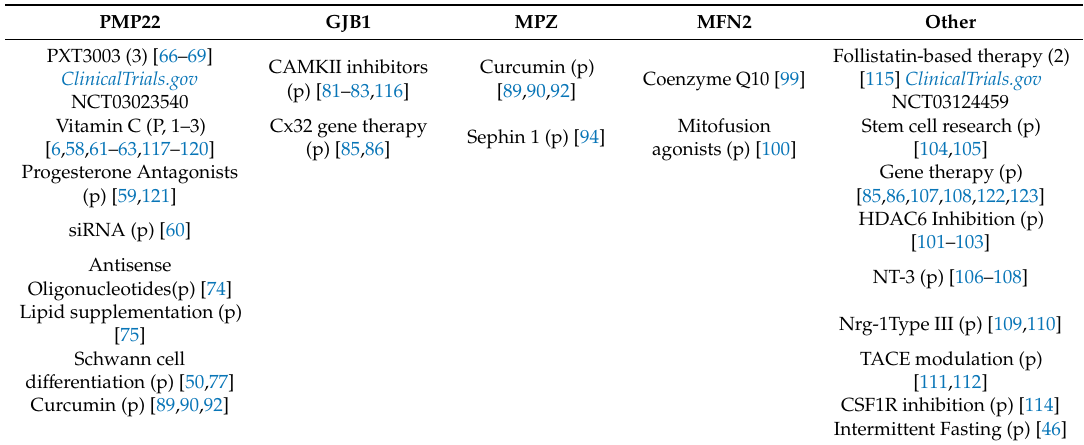
Table 2. Therapy investigations